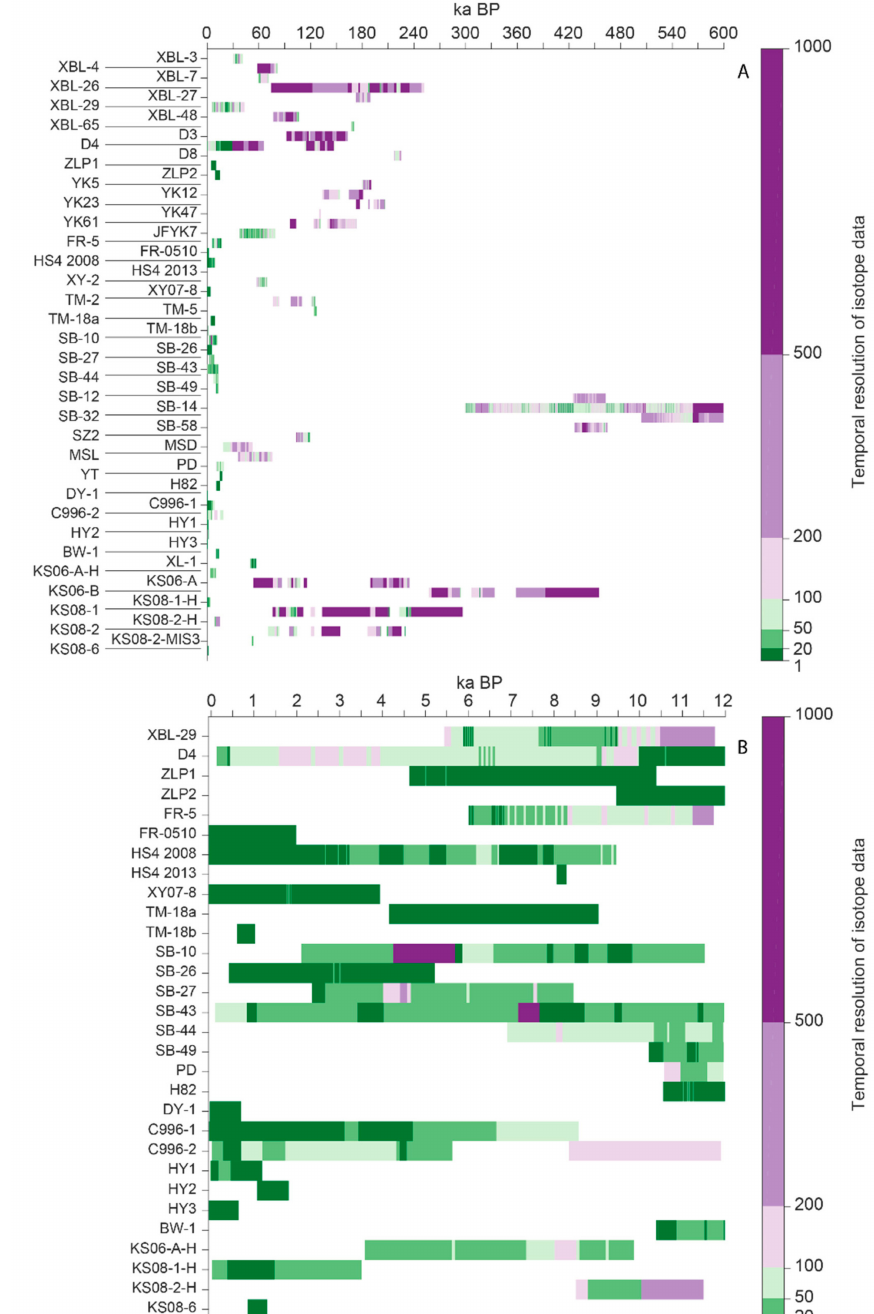
Figure 3. Temporal distribution of stalagmite δ 18 O records from China in SISAL_v1 [19]. Panel ( A ) shows all available records and panel ( B ) focuses on the last 12 kyr. The color bar represents the temporal di ff erence among consecutive isotopic samples in years. Labels on the y -axis are the entity_names as in Table 1. Entities are sorted by